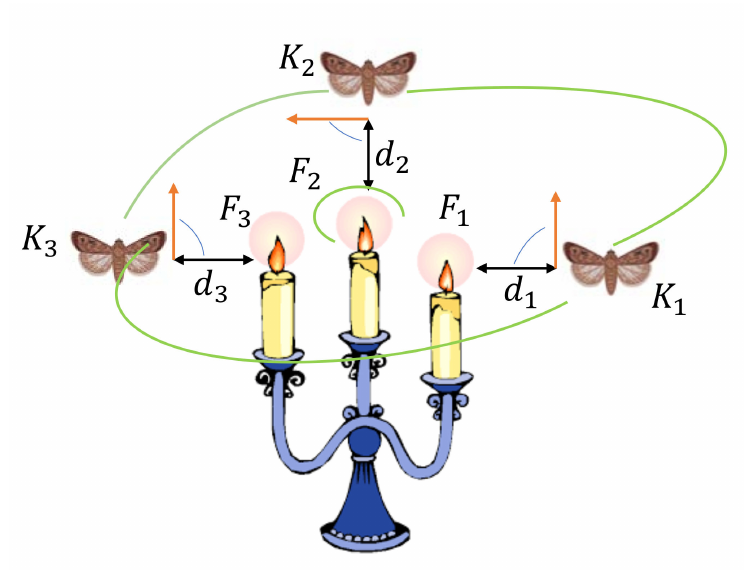
Figure 3. Navigation movement of moths in moth flame optimization algorithm